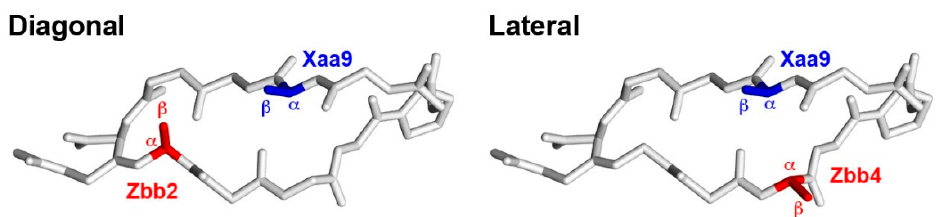
Figure 3. The backbone of the solution structure of an analogue of the parent YKL peptide (pdb code 1JY9 [51]) along with the intended diagonal (left) and lateral (right) interacting residues. The backbone and DPro side chains are shown in white. The C α and C β of the negatively charged residues are shown in red, and C α and C β of the positively charged residues are shown in blue.